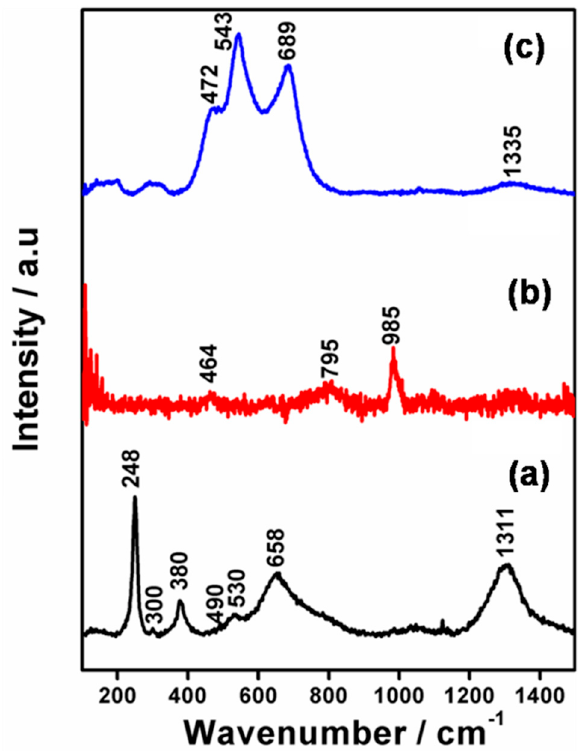
Figure 2. Raman spectra of ( a ) Fe on TC, ( b ) Ni on TC, and ( c ) NiFe-LDH deposited on TC sheet.